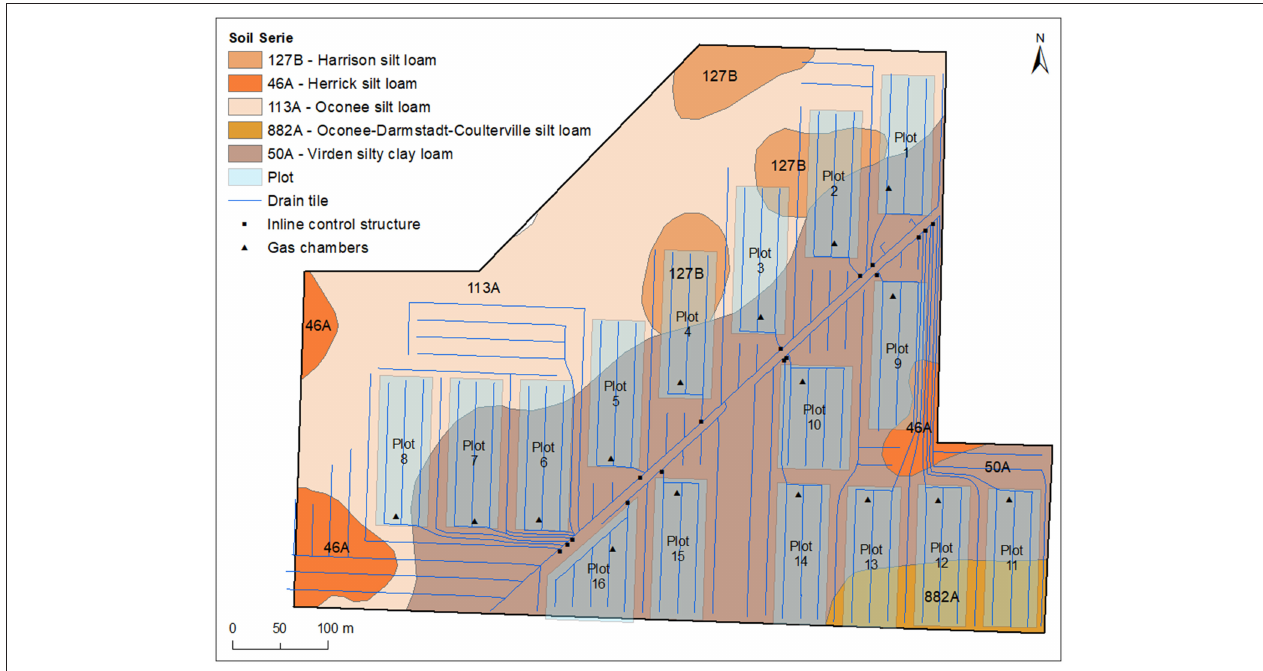
FIGURE 1 | Experiment and drainage design layout at the University of Illinois Dudley Smith Farm, Illinois, U.S.